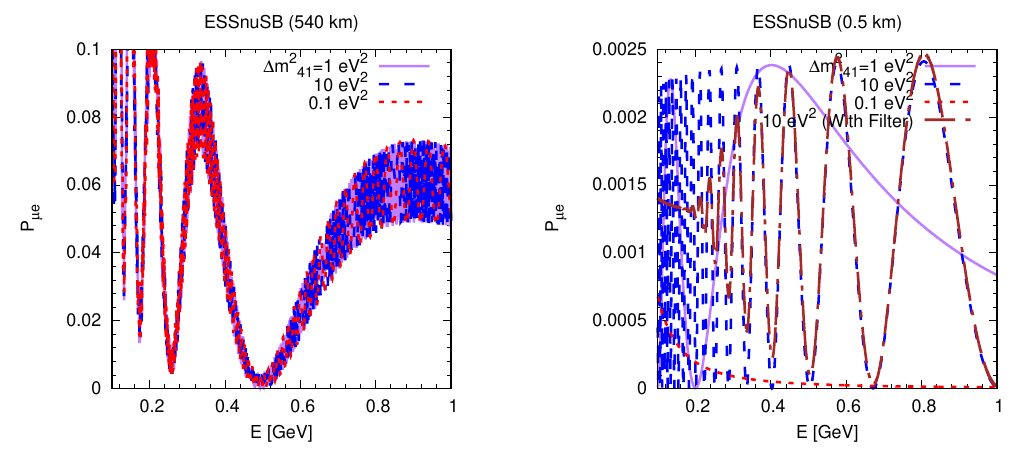
Figure 1 . Appearance channel oscillation probability for neutrinos as a function of the neutrino energy E . The left panel is for ESSnuSB with a baseline length of 540 km, whereas the right panel is for ESSnuSB with a baseline length of 0.5 km. The solid purple curve corresponds to (cid:1) m 2 = 1 eV 2 , the long-dashed blue one to (cid:1) m 2 = 10 eV 2 , and (cid:12)nally, the dashed green one 41 41